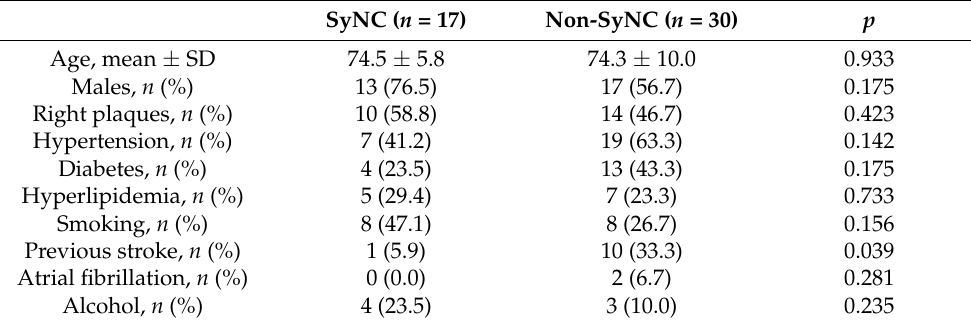
Table 1. Demographic and risk factors between symptomatic nonstenotic carotid disease and non- symptomatic nonstenotic carotid disease groups. SyNC ( n = 17)